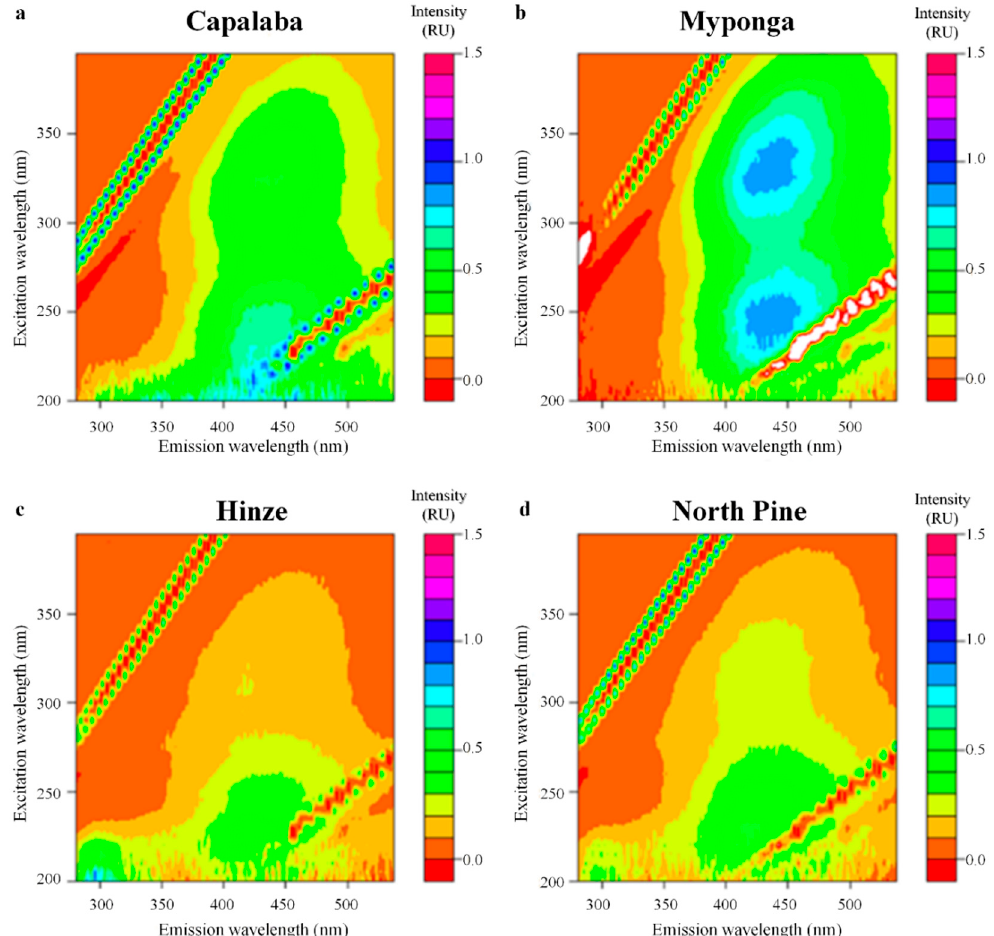
Figure 7. Excitation-emission matrix (EEM) of four raw waters. ( a ) Capalaba; ( b ) Myponga; ( c ) Hinze; and ( d ) North Pine.